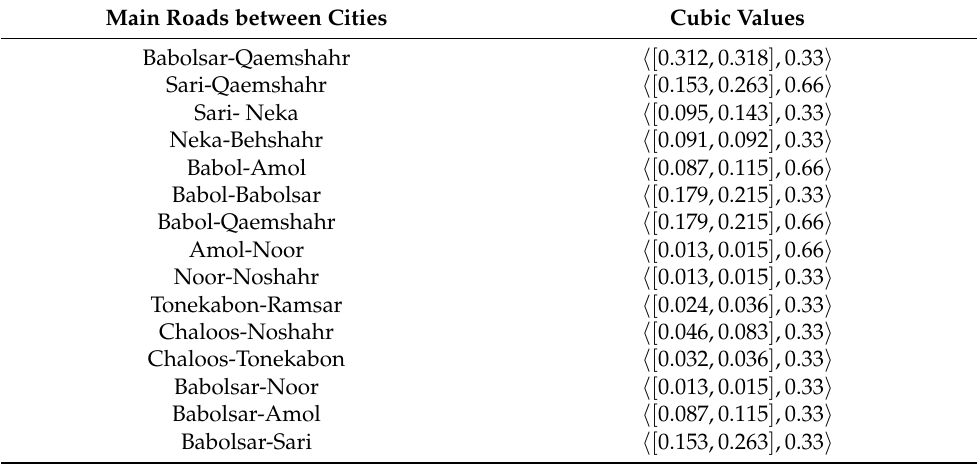
Table 7. Cubic values between cities. Main Roads between